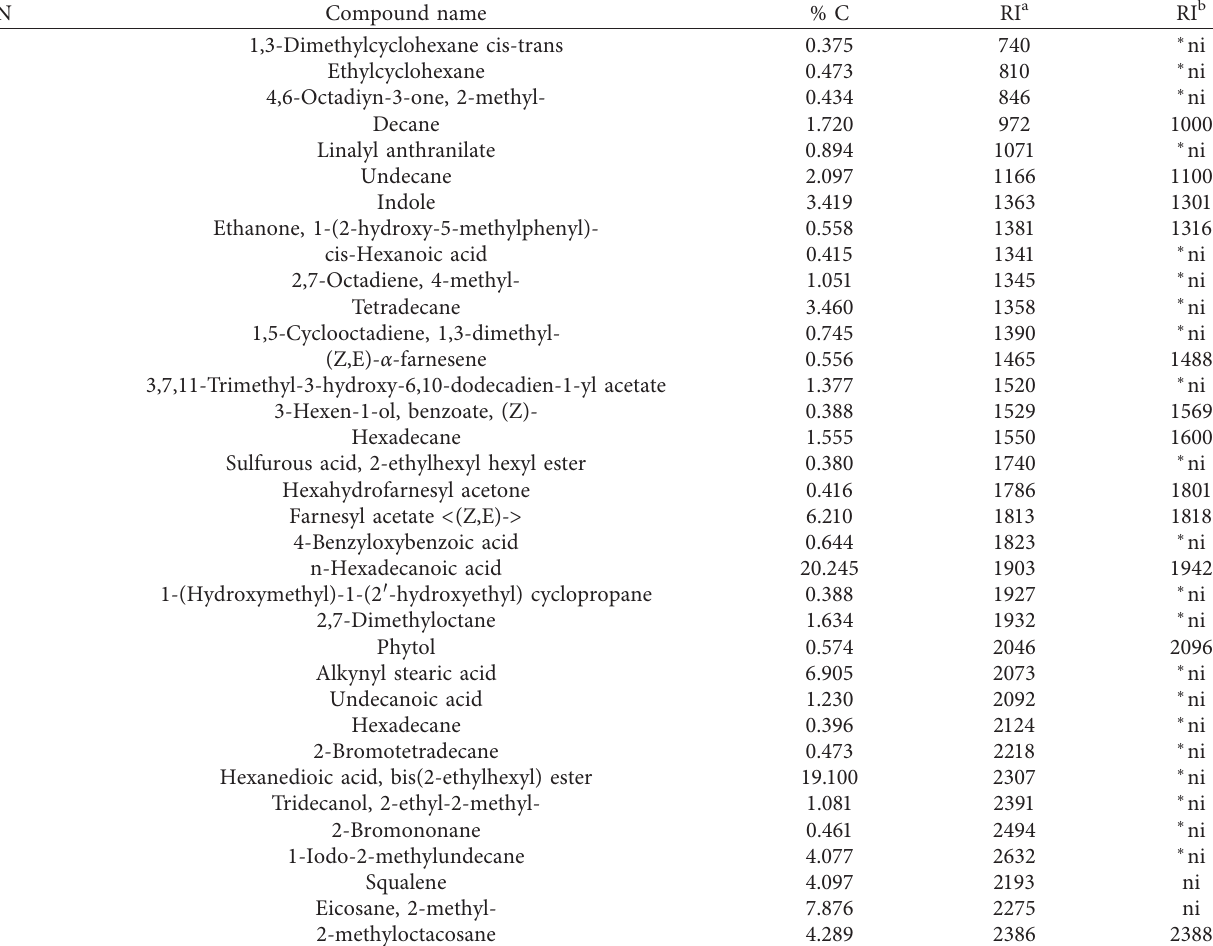
Table 1: Chemical composition of the leaf essential oil of Chrysophyllum albidum as determined by GC-MS.